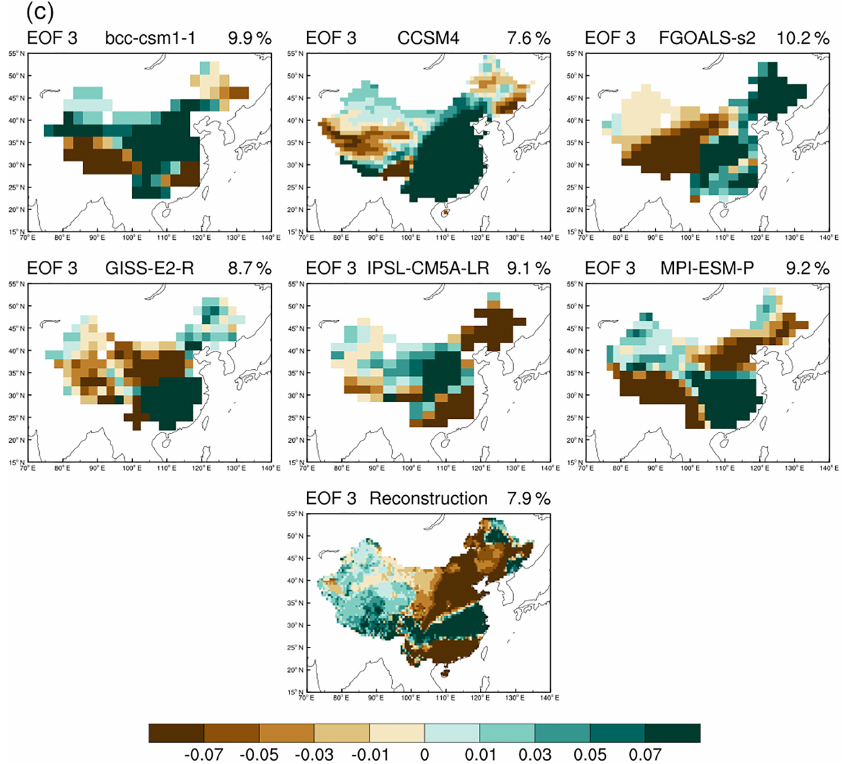
Figure 8. (a) Empirical orthogonal function (EOF) 1 of the MJJAS mean precipitation anomalies for China during the interval AD1470– 1849. (b) Empirical orthogonal function (EOF) 2 of the MJJAS mean precipitation anomalies for China during the interval AD1470–1849. (c) Empirical orthogonal function (EOF) 3 of the MJJAS mean precipitation anomalies for China during the interval AD1470–1849.